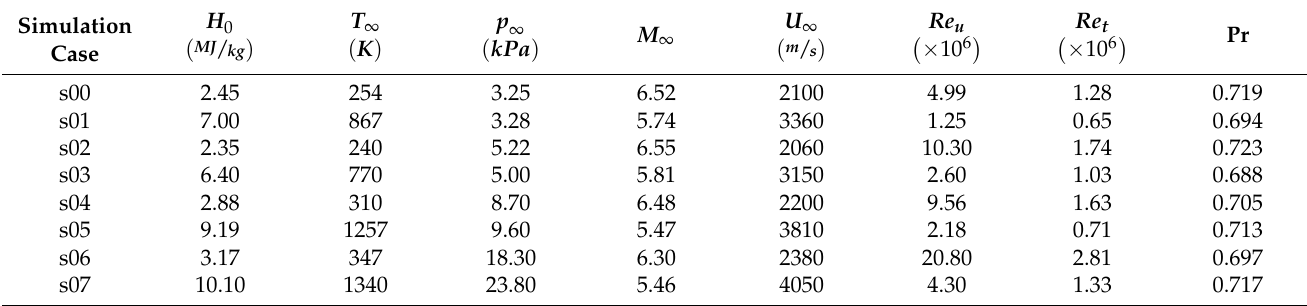
Table 1. Flow condition for the simulation